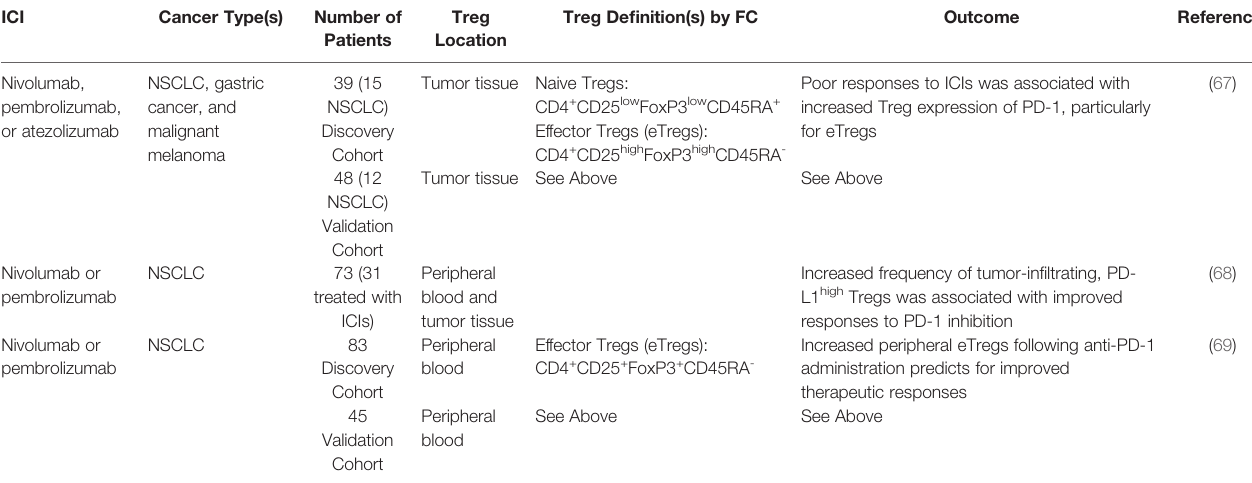
TABLE 2 | Studies exploring regulatory T cells as a predictor of responses to immune checkpoint inhibition.